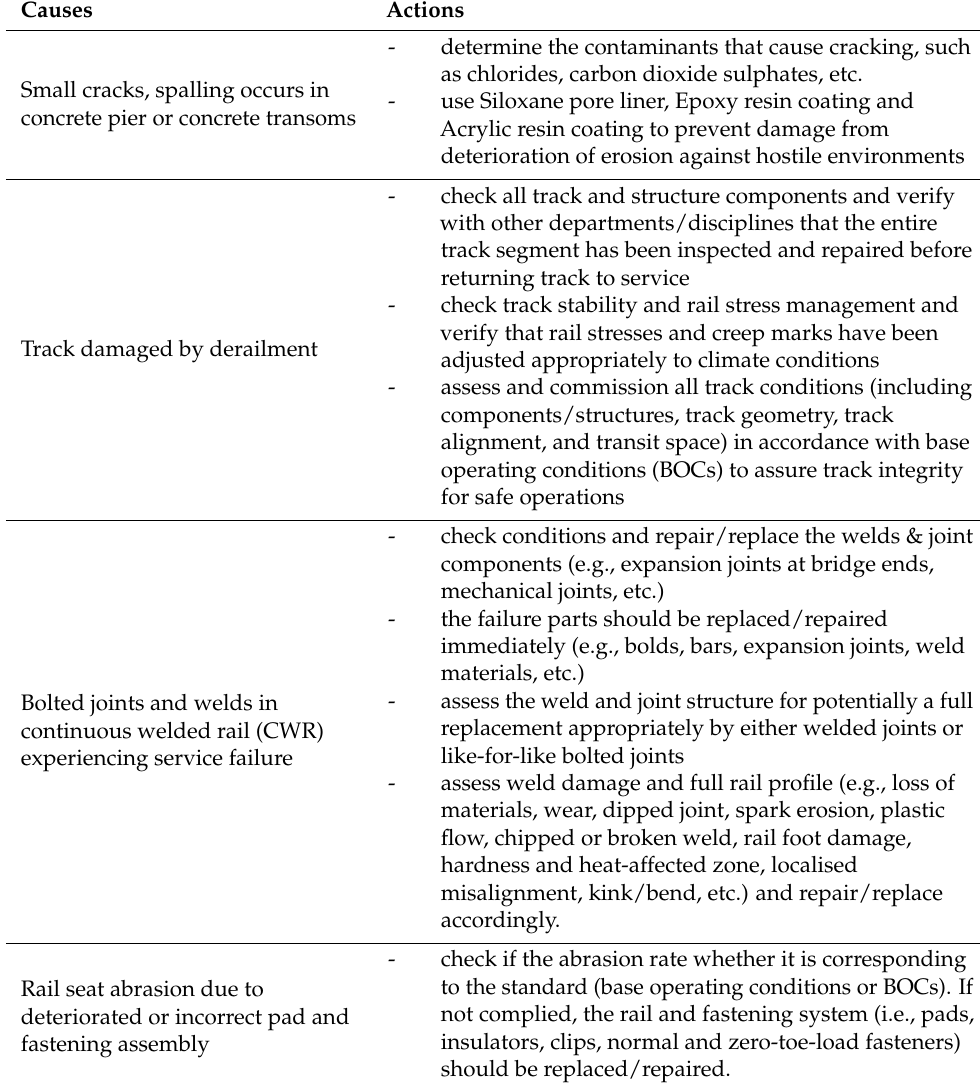
Table 6. List of Maintenance Replacement and Repair